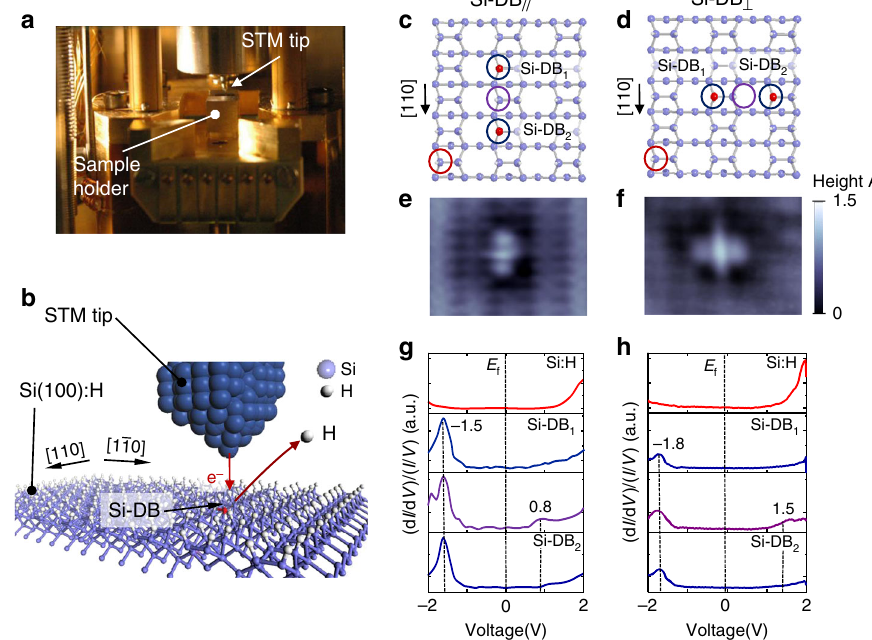
Fig. 1 Topographical and electronic aspects of Si-DB interactions. a Photography of the inside scanner of the low-temperature (9 K) scanning tunneling microscope. b ball and stick sketch of the Si(100):H surface excited by the tungsten tip of the microscope during the local desorption process of an H atom. c , d Ball and stick sketches of the Si-DB // and Si-DB ⊥ made of two Si-DBs oriented parallel ( c ) or perpendicular ( d ) to the [110] direction of the silicon lattice. The blue, purple, and red circles indicate the positions where the (d I /d V )/( I / V ) measurements are done. e , f (34.6 × 36 Å 2 ) STM topographies ( V = +1.7 V, I = 33 pA) of the corresponding Si-DB I /d V )/( I / V ) //- ⊥ having two Si-DBs separated by a fully hydrogenated silicon dimer. g , h Normalized (d curves measured on the Si-DB // and Si-DB ⊥ . The (d I /d V )/( I / V ) curves on the Si:H, the Si-DB positions, and in between the Si-DB are red, blue, and